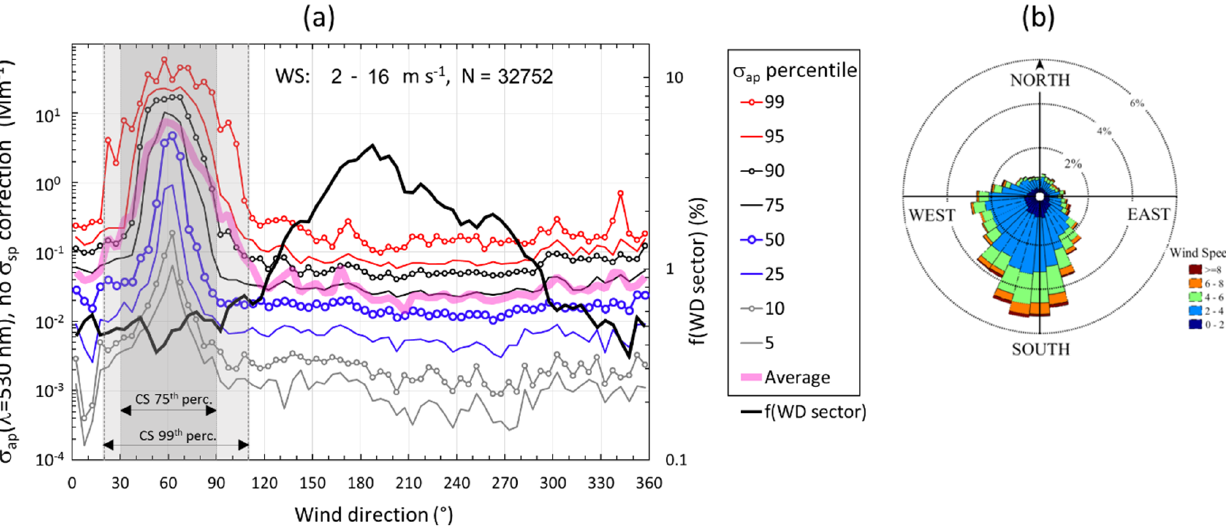
Figure 4. Wind and absorption coefficient. (a) Hourly averaged non-scattering-corrected absorption coefficients ( σ ap,nsc , Eq. 1) observed at wind speed WS > 2ms − 1 in 5 ◦ wind direction (WD) sectors. The lines present the percentiles of the cumulative σ ap,nsc distribution in each WD sector. f (WD sector): fraction of wind data from each sector. CS 75th perc.: contamination sector determined from the 75th percentiles of the cumulative σ ap,nsc distribution. CS 99th perc.: contamination sector determined from the 99th percentiles of the cumulative σ ap,nsc distribution. (b) Distribution of WS and WD as a wind rose. Table 3. Noise and detection limits of eBC concentrations calculated from the noise of the absorption coefficients presented in Table